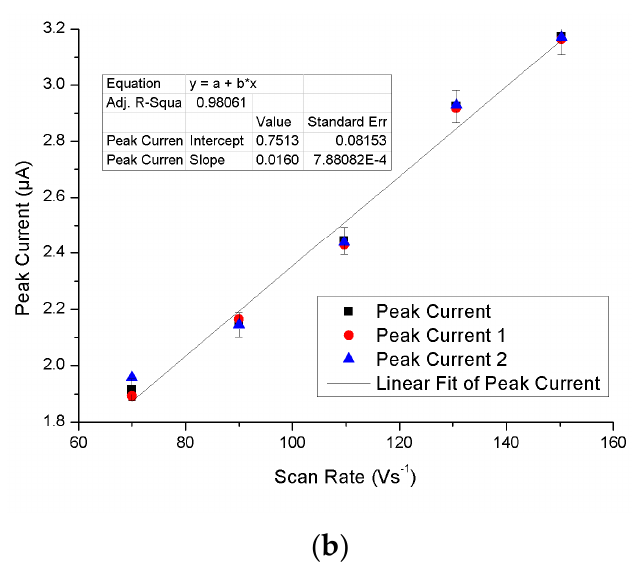
Figure 9. ( a ) Cyclic voltammogram of 1 × 10 − 4 M UA at different scan rates (70, 90, 110, 130, and 150 mV ∙ s − 1 ) in 0.1 M PBS (pH 7.0); ( b ) Effect of different scan rates on the oxidation peak current of 1 × 10 − 4 M UA at the PMCPE.